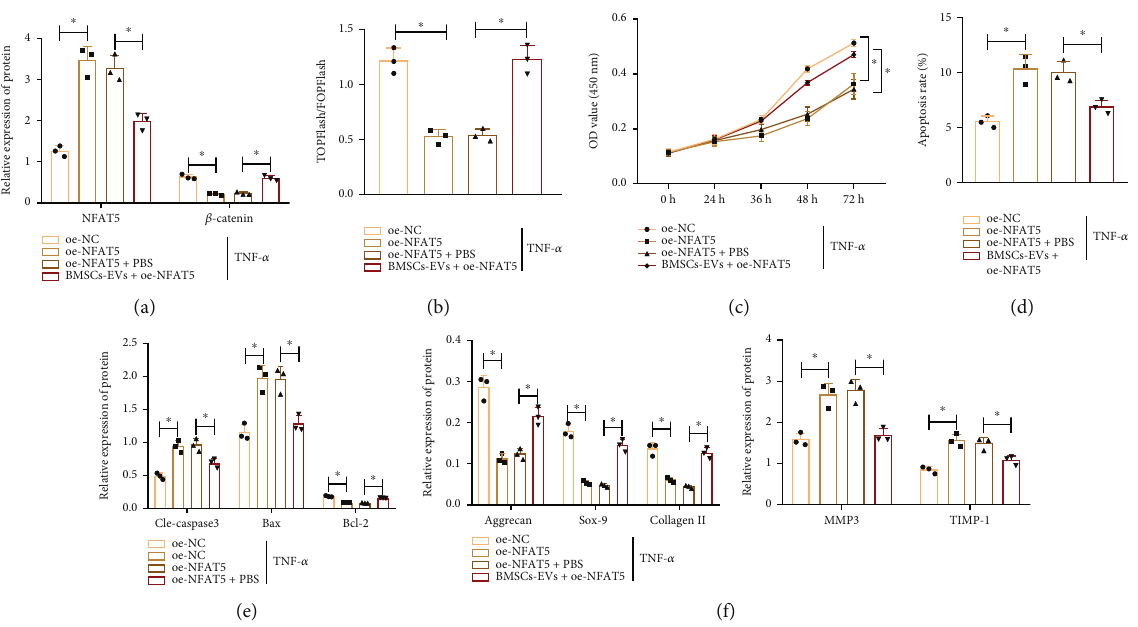
Figure 7: miR-31 in hBMSC-EVs targets NFAT5 to inhibit NPC apoptosis and ECM degradation in NPCs: (a) protein expression of NFAT5 and β -catenin in TNF- α -exposed NPCs treated with oe-NFAT5 or combined with BMSCs-EVs determined by Western blot; (b) the transcription activity of TCF/LEF in TNF- α -exposed NPCs treated with oe-NFAT5 or combined with BMSCs-EVs determined by TOPFlash; (c) proliferation of TNF- α -exposed NPCs treated with oe-NFAT5 or combined with BMSCs-EVs determined by CCK-8 assay; (d) apoptosis of TNF- α -exposed NPCs treated with oe-NFAT5 or combined with BMSCs-EVs determined by fl ow cytometry; (e) protein expression of apoptosis-related genes cleaved caspase-3, Bax, and Bcl-2 in TNF- α -exposed NPCs treated with oe-NFAT5 or combined with BMSCs-EVs determined by Western blot; (f) protein expression of ECM-related genes in TNF- α -exposed NPCs treated with oe-NFAT5 or combined with BMSCs-EVs determined by Western blot. ∗ p < 0 : 05 . Cell experiments were repeated three